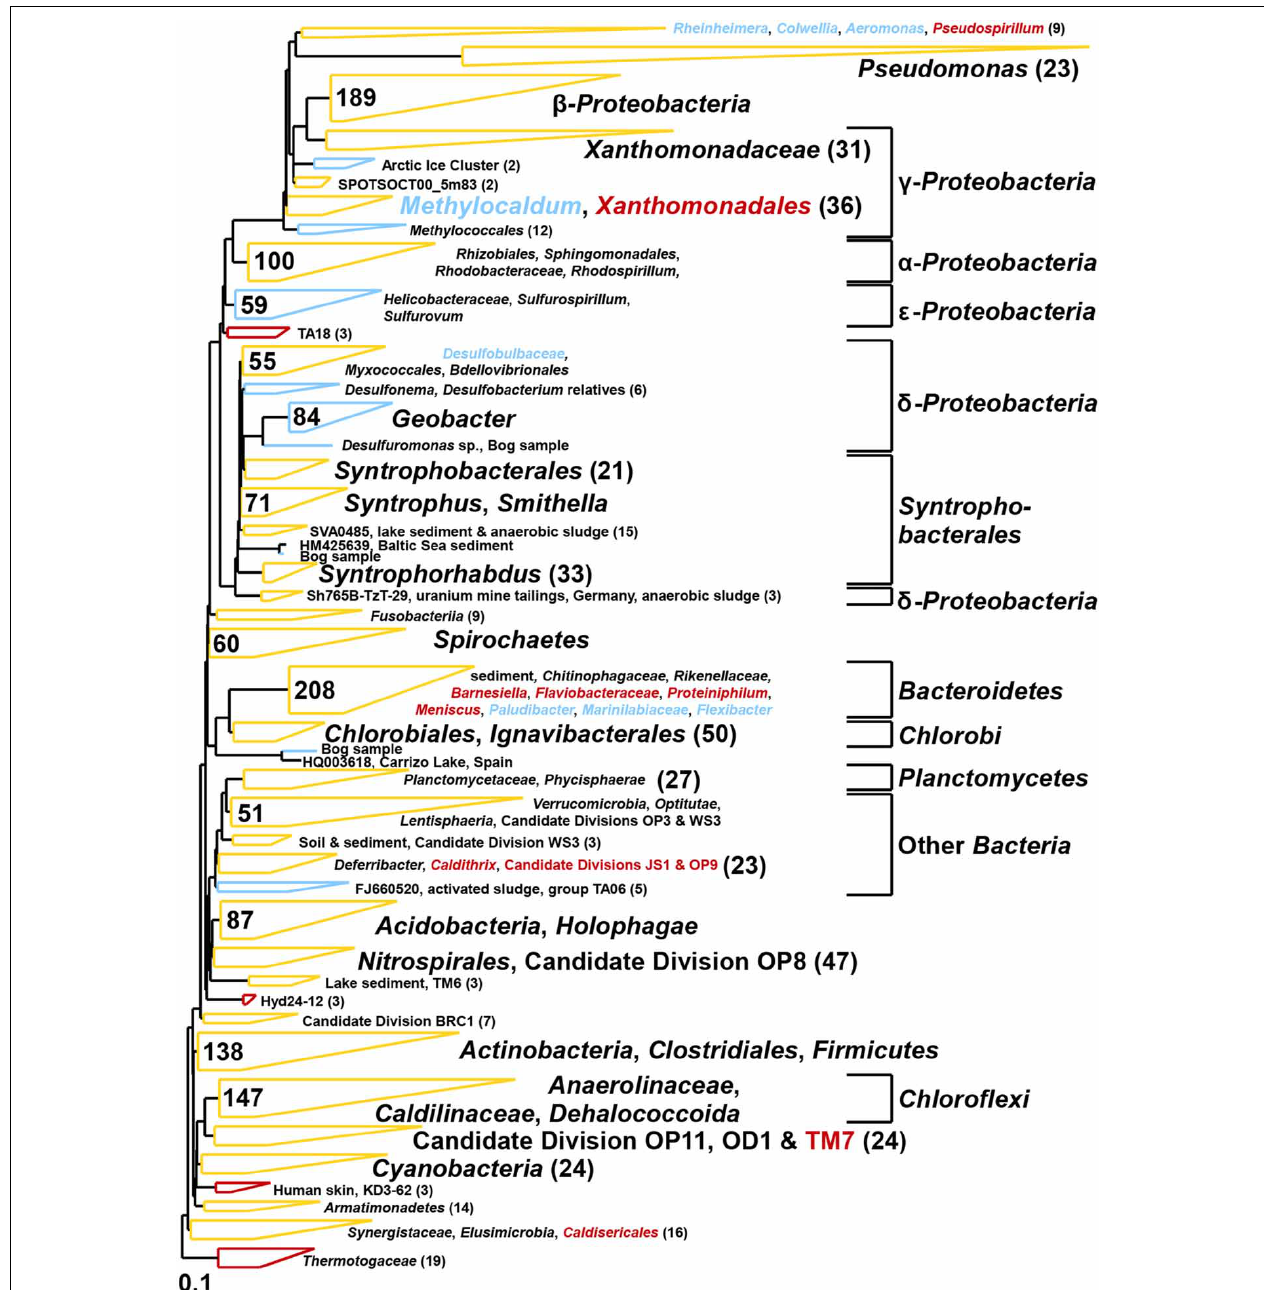
FIGURE 9 | Composite maximum parsimony phylogenetic tree constructed by incorporating bacterial 16S rRNA gene sequences of the bog sediment (blue) and the AD sludge (red) into an existing